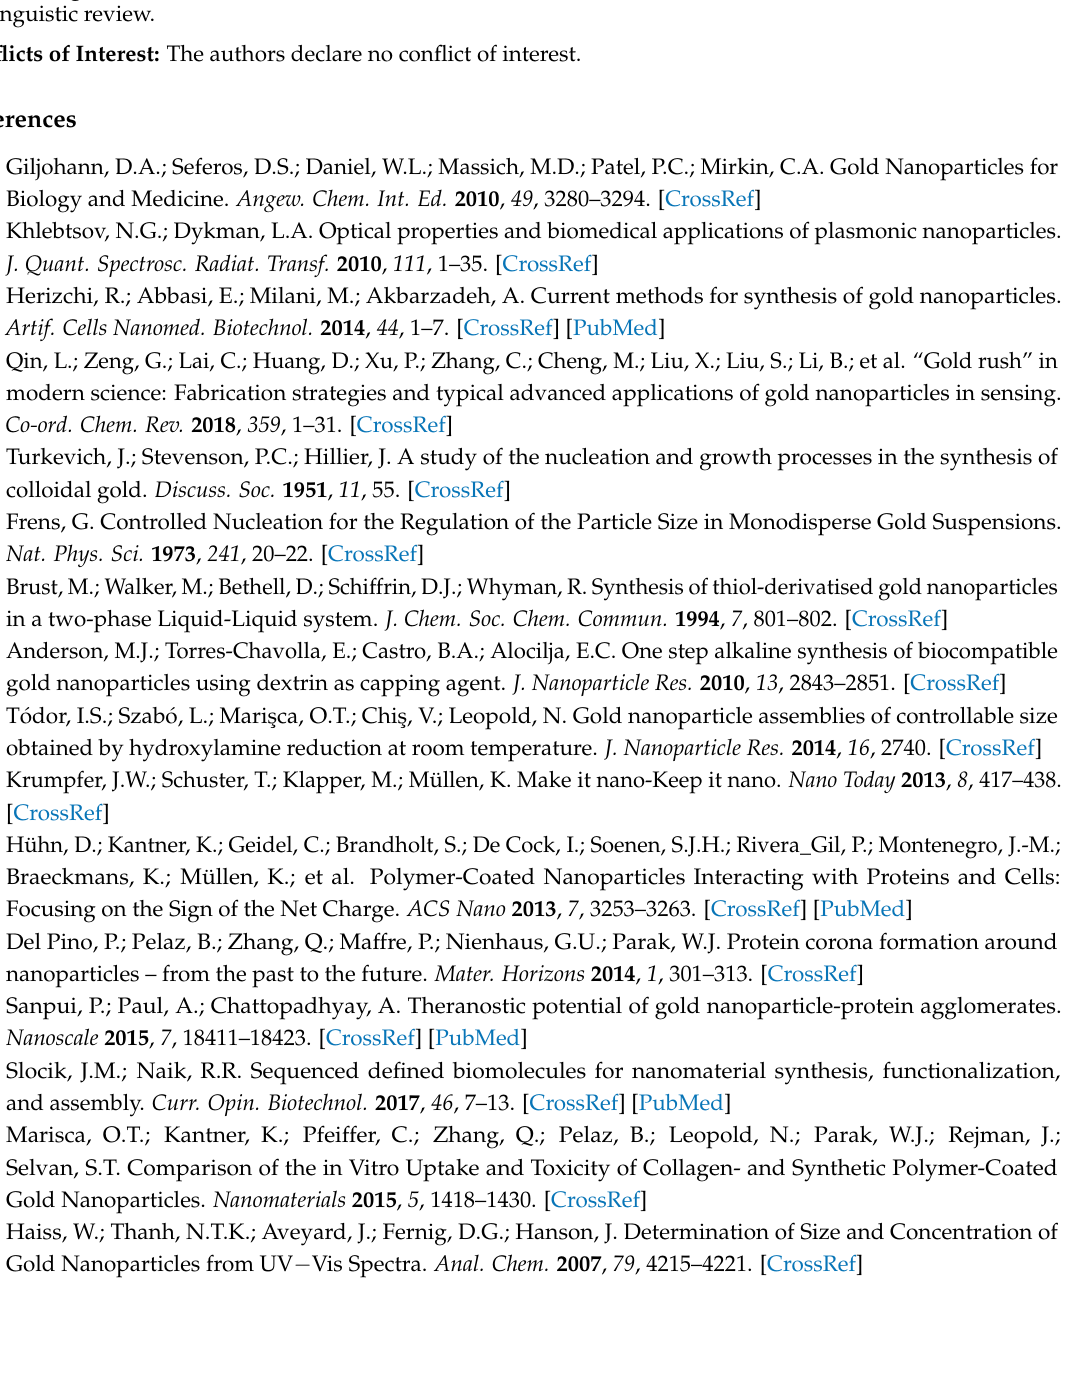
s1, Figure S1. Size distribution of clg-AuNPs measured by dynamic light scattering (DLS) (A). Zeta potential distribution of clg-AuNPs (B). Figure S2. DLS measurements showing clg-AuNPs stability in cell culture medium without or with